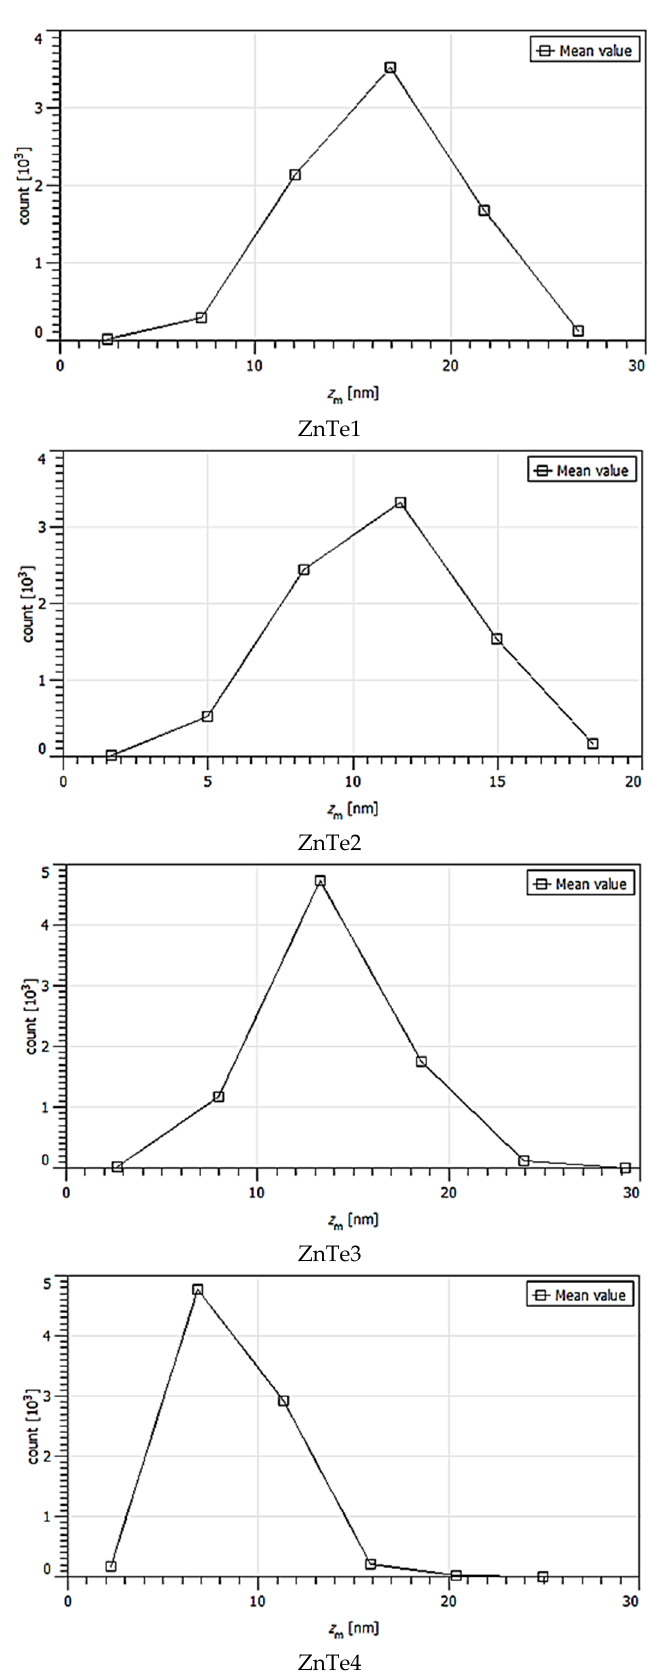
Figure 5. Mean value statistic variation onto surfaces of ZnTe1,2,3,4 thin films.